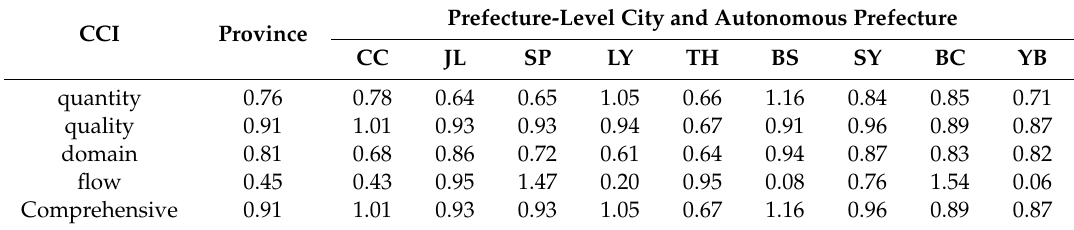
Table 3. The carrying capacity index (CCI) of Jilin.